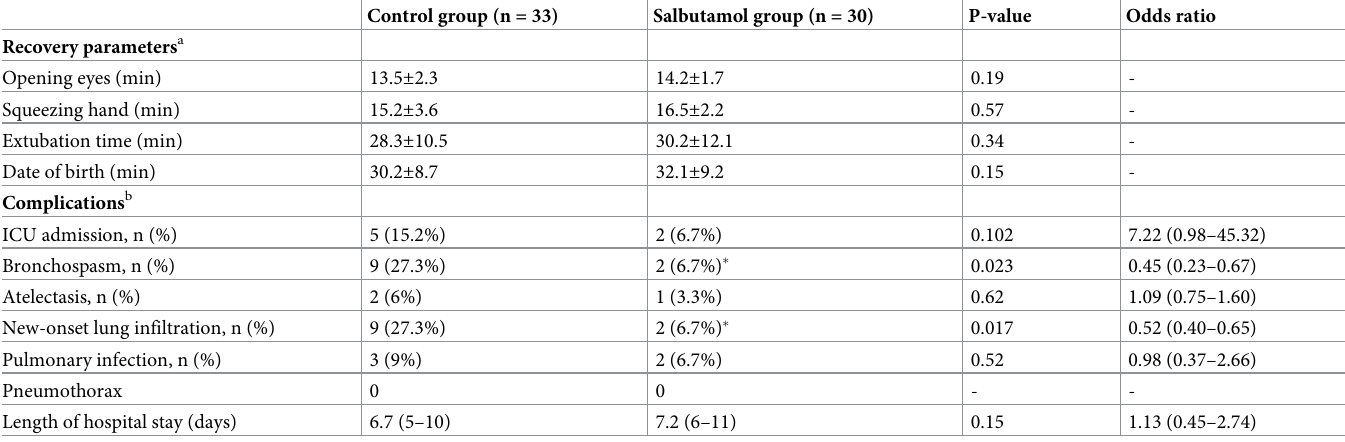
Table 3. Recovery parameters and postoperative pulmonary